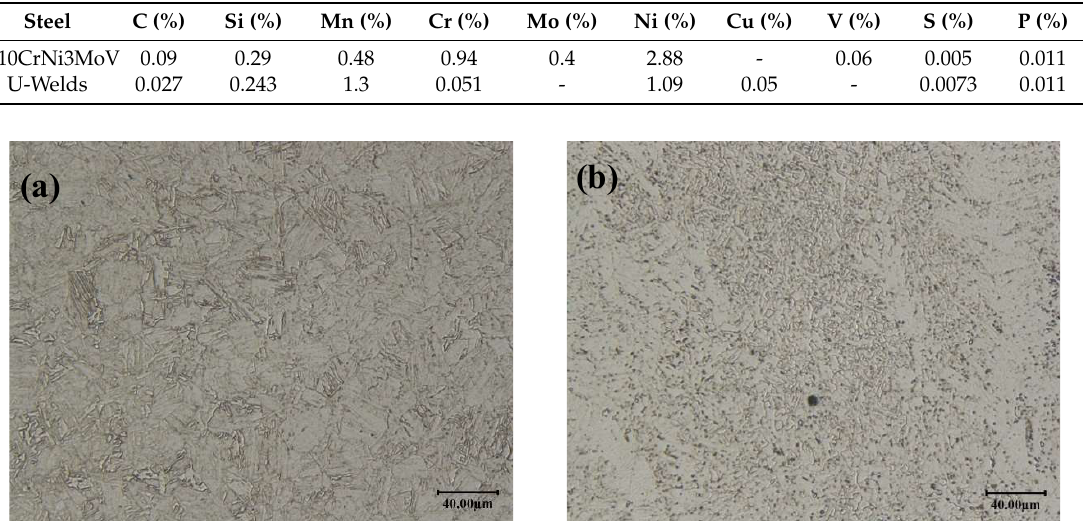
Table 1. Comparison of the chemical composition between 10CrNi3MoV steel and under-matched welds.